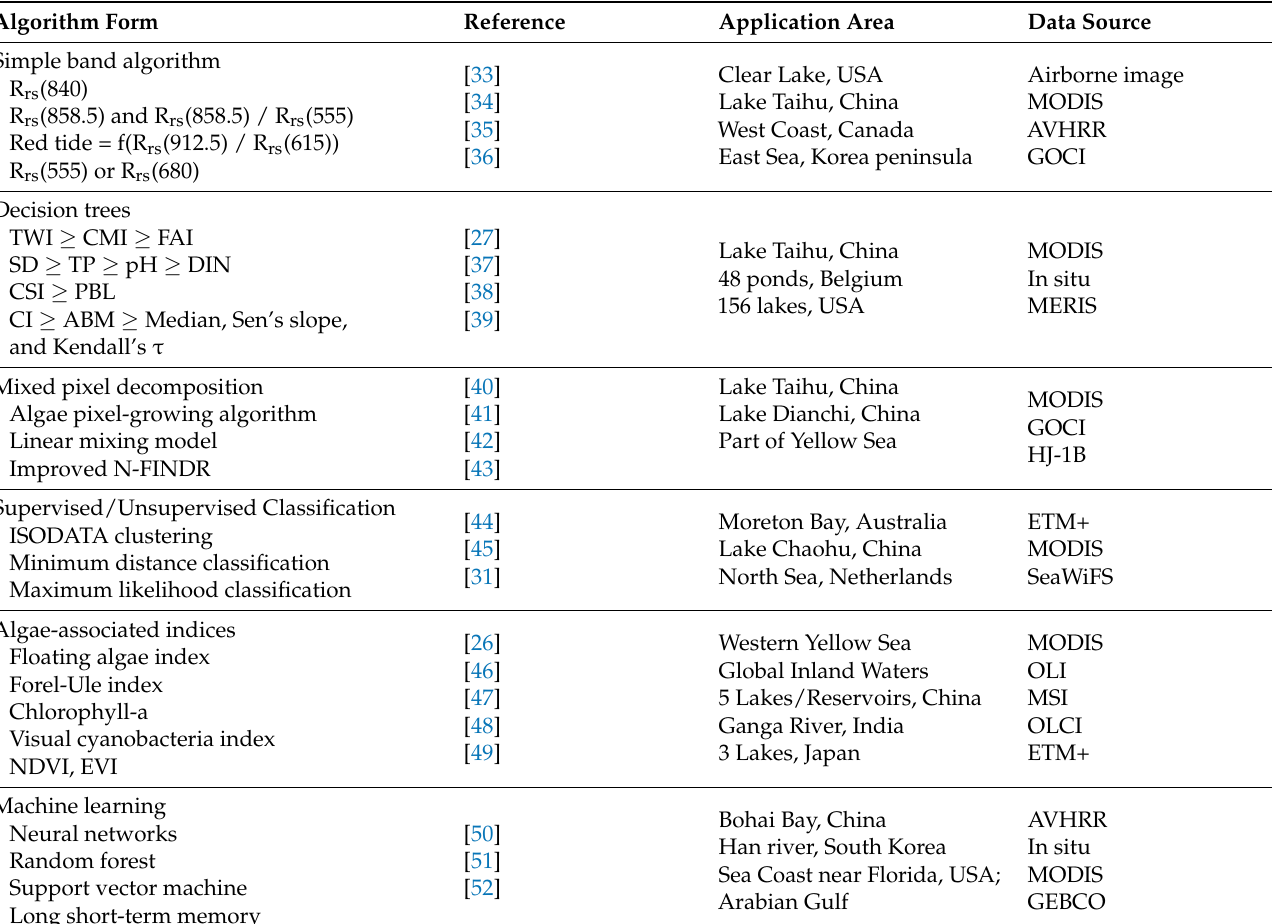
Table 1. Examples of CBs identification algorithms and their application area.